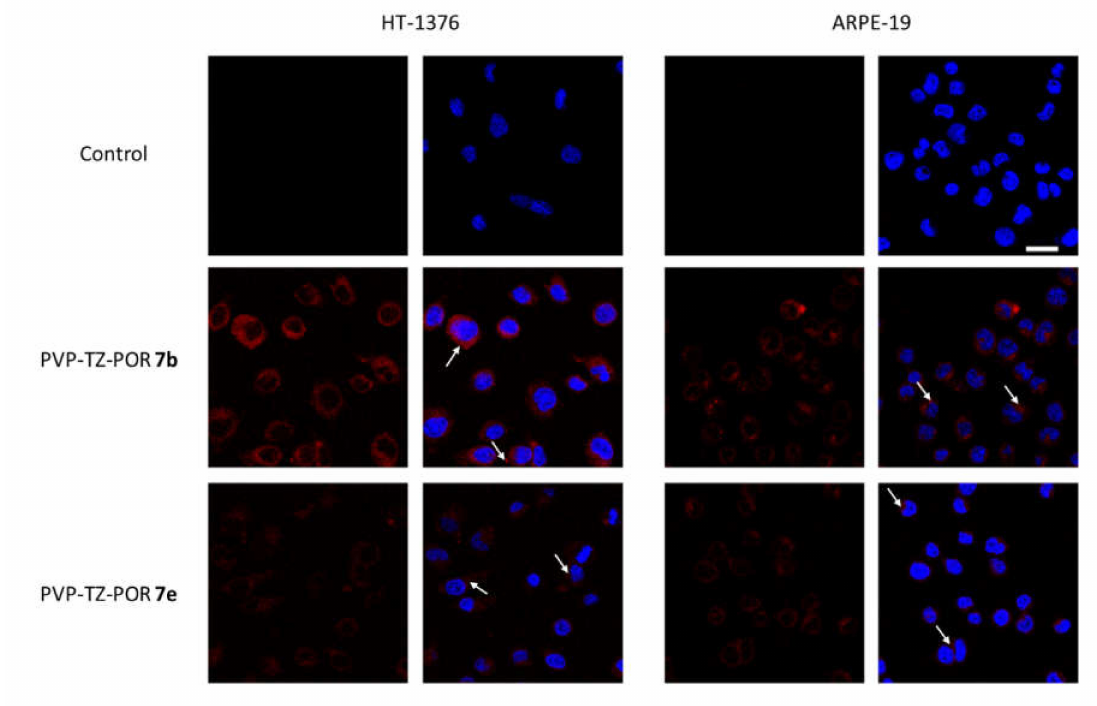
Figure 4. Representative fluorescence images of HT-1376 and ARPE-19 cell lines incubated with 10 µ M of PSs PVP-TZ-POR 7b (red) and 7e (red) for 4 h in darkness and cell nucleus stained with 4’,6-diamidino-2-phenylindole (DAPI; blue). Scale bar 20 µ